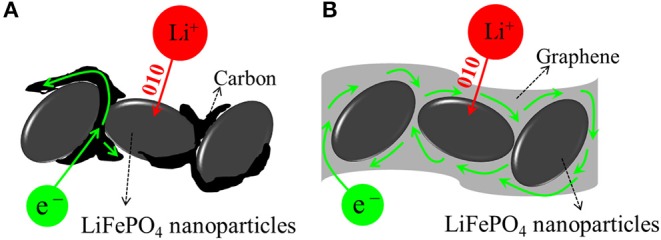
Electron transfer pathway in LiFePO4/graphene (A) and LiFePO4/C (B) electrodes.